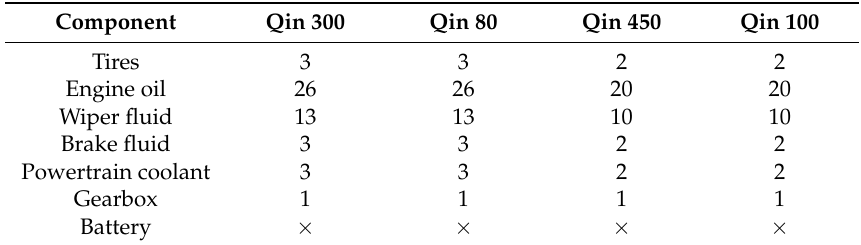
Table 4. The maintenance and replacement of vehicle materials.